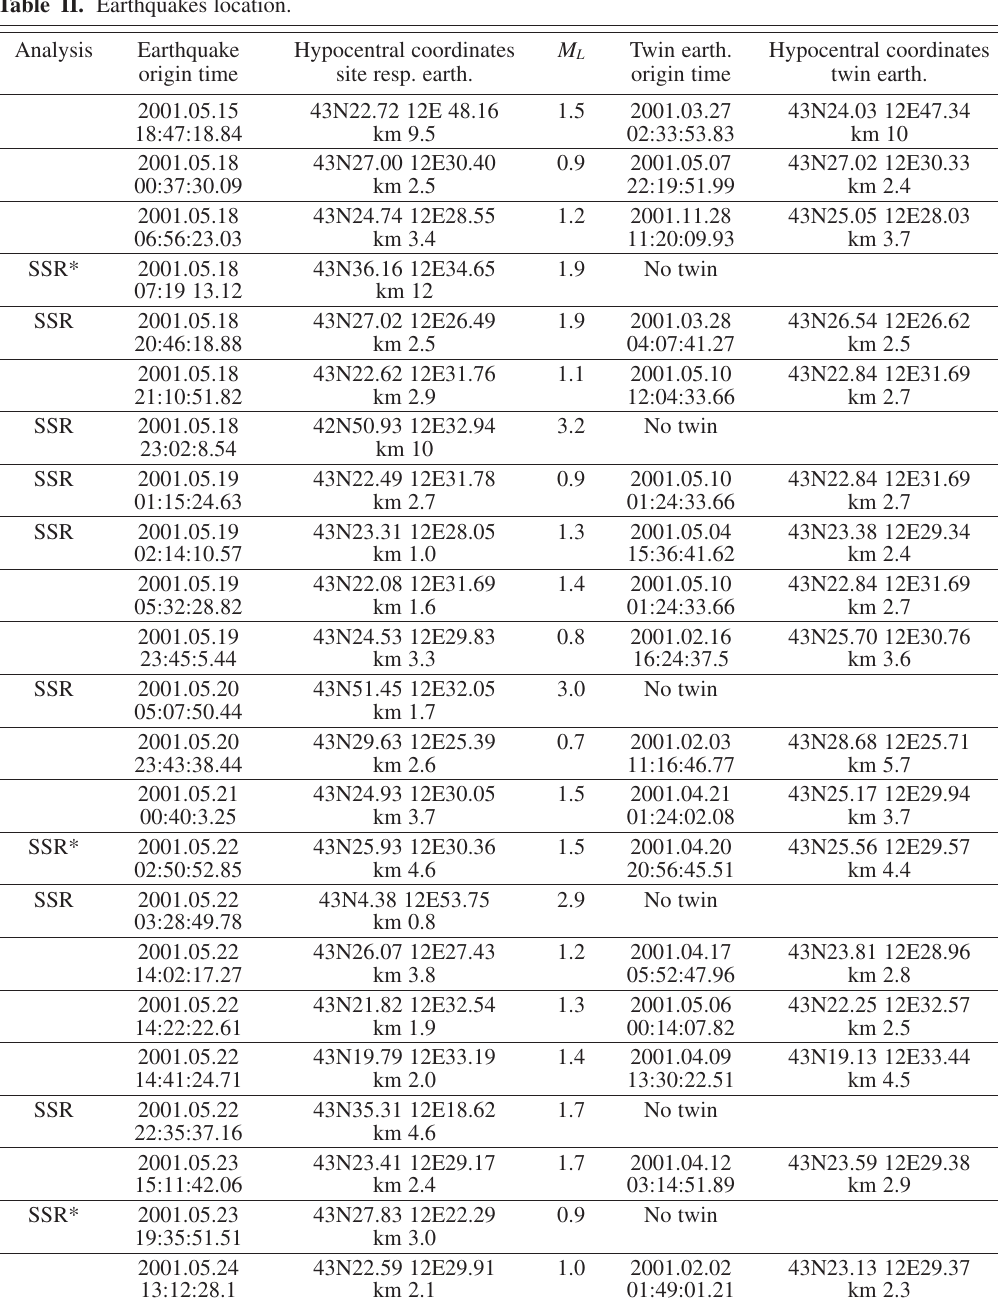
Table II. Earthquakes